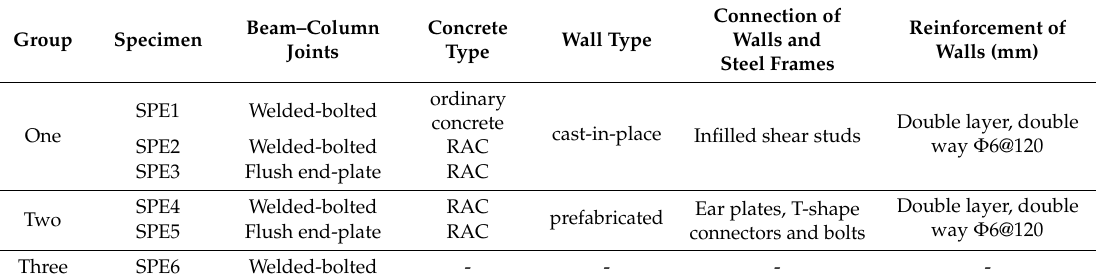
Table 1. Main parameters of specimens.